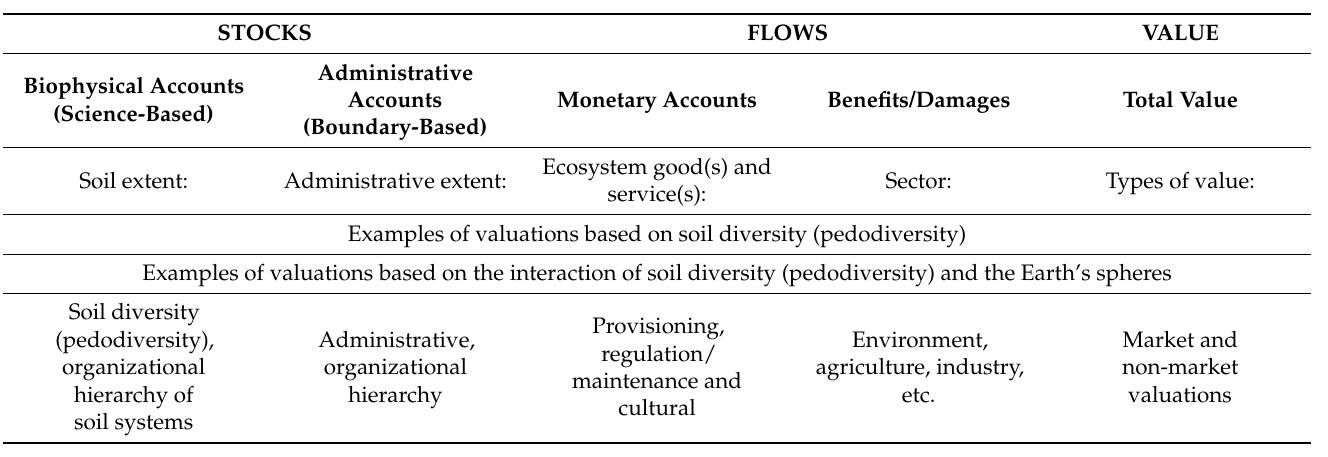
Table 2. A conceptual overview of the accounting framework for a systems-based approach in the ecosystem services (ES) valuation of various soil ecosystem goods and services based on soil diversity (pedodiversity) (adapted from Groshans et al., 2018